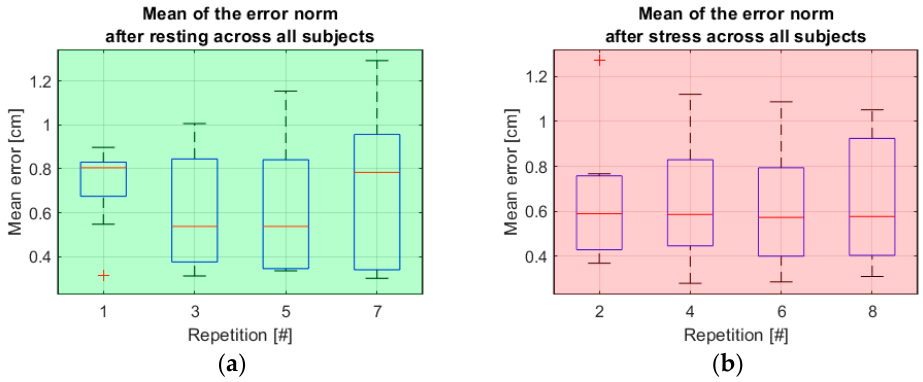
Figure 5. Boxplots of the error during static tests specifically after resting phases and after completion of one task series. ( a ) Boxplot of the mean error in static tests executed after a resting phase; ( b ) Boxplot of the mean error in static tests executed after completion of a task series, before a resting phase.